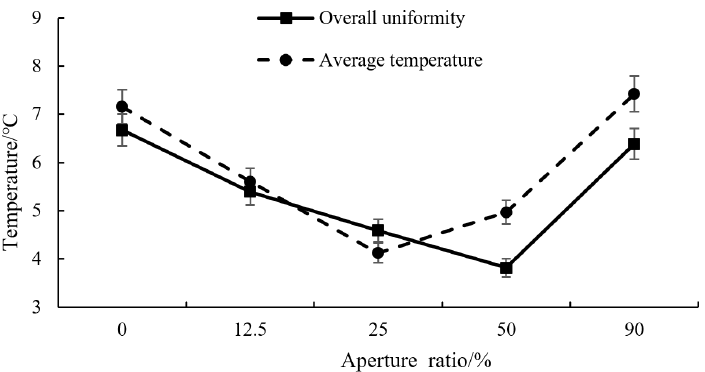
Figure 5. The influence of different aperture ratios on the average temperature inside the cabinet.